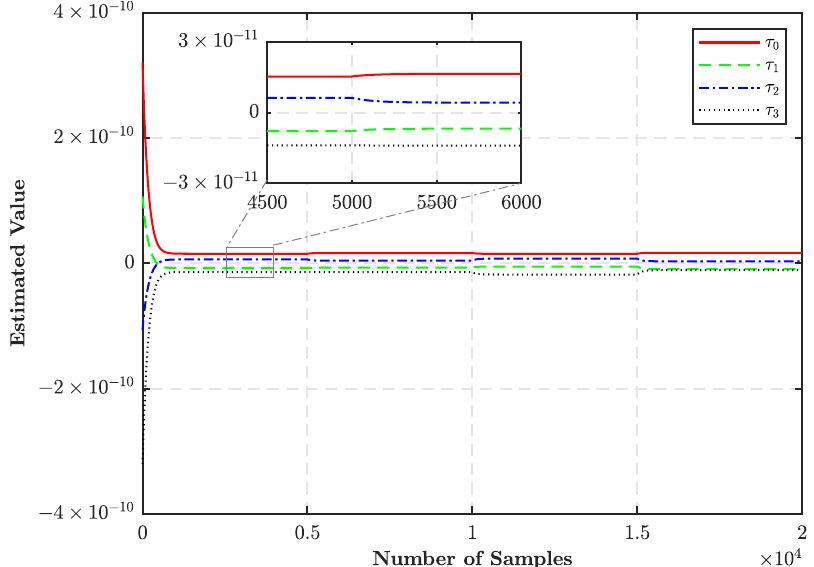
Figure 14. The calculation speed of the proposed estimation algorithm with random white noise at 5000, 10,000 and 15,000 sample